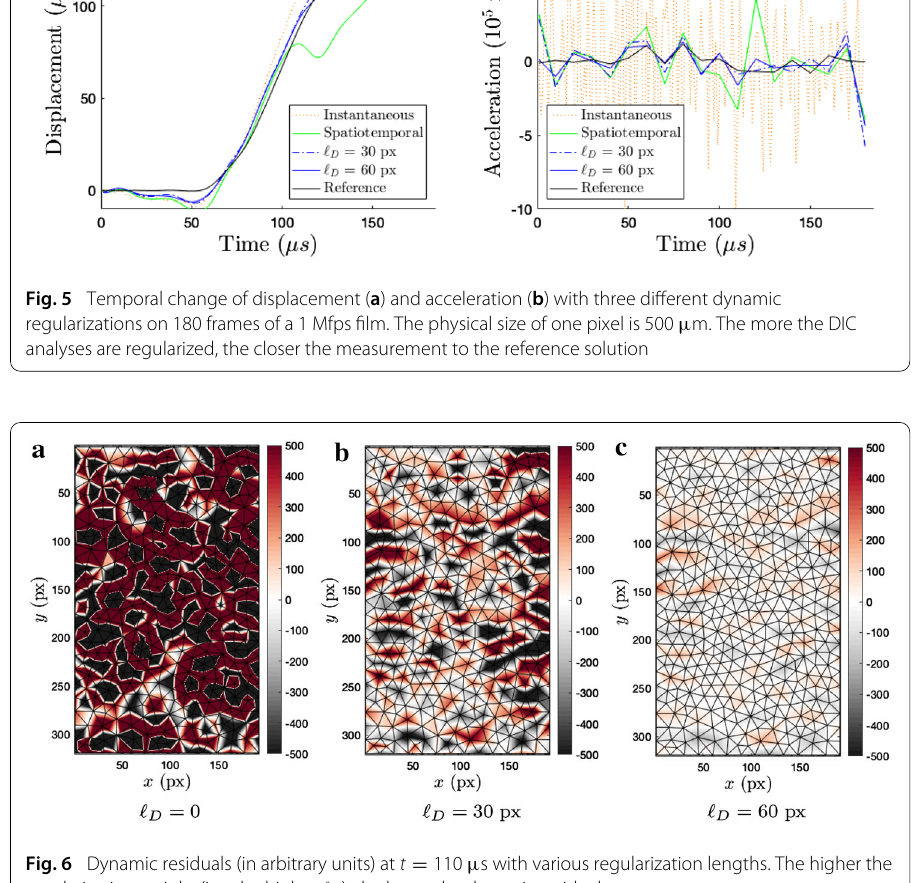
Fig. 6 Dynamic residuals (in arbitrary units) at t = 110 µ s with various regularization lengths. The higher the regularization weight (i.e., the higher (cid:8) D ), the lower the dynamic